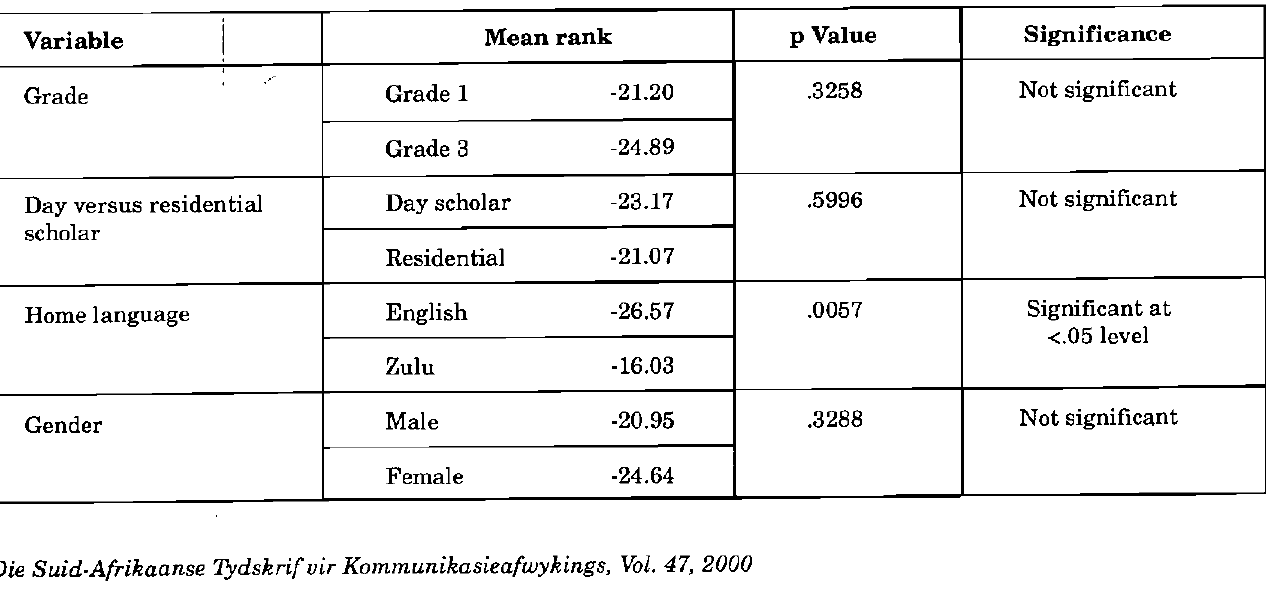
Die Suid-Afrikaanse Tydskrif vir Kommunikasieafwykings, Vol. 47, 2000